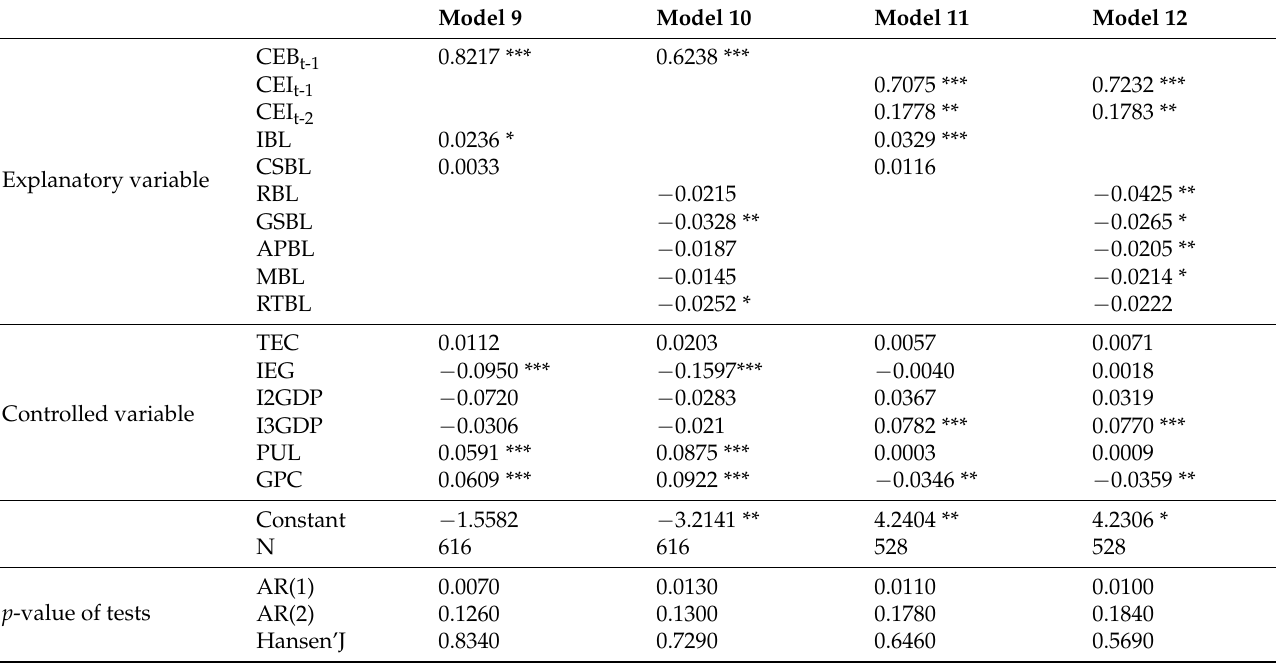
Table 4. Results of the parameter estimation and test outcomes of Sys-GMM